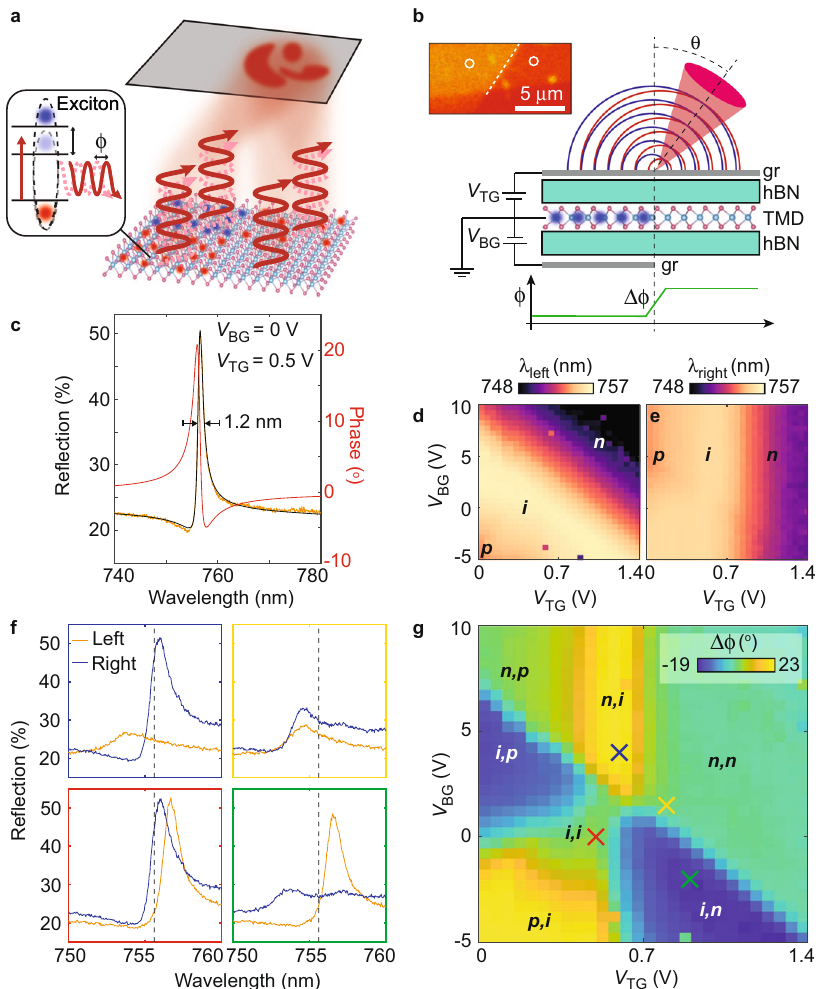
Fig. 1 Continuously tunable phase patterning in a van der Waals heterostructure. a Schematic of our approach: patterned electrostatic doping of atomically thin transition metal dichalcogenides (TMDs) allows for spatial control of the exciton resonance (inset). Thus, a continuously tunable phase pro fi le is imparted on the re fl ected wavefront, enabling wide-ranging possibilities for beam control. b Schematic of SG-FET structure. Since the bottom gate only covers part of the device, the phase can be tuned independently in the two sides. The phase discontinuity in the re fl ected wavefront causes the two halves to constructively interfere at an angle in the far fi eld. Inset: zoomed-in optical microscope image of the device, with gate edge indicated by white dashed line. c Representative re fl ection spectrum (orange) from left side of gate edge in intrinsic regime ( V BG = 0 V and V TG = 0.5 V), with asymmetric resonance fi t (black), which allows for extracting the phase (red). d , e Gate dependence of λ left and λ right , respectively (locations indicated by circles in inset of b ). The exciton resonance blue-shifts upon electrostatic doping. While λ left depends on 8 V TG + V BG , λ right is largely independent of V BG . The intrinsic regime appears at an offset of V TG = 0.5 V, likely due to charge collection at the top gate. The small voltage range of the intrinsic regime suggests some doping via in-gap states. f Re fl ection spectra from left (orange) and right (blue) side of gate edge at different gate voltage combinations shown as correspondingly colored crosses in g . Dashed gray line indicates λ 0 = 755.6 nm. g Gate dependence of phase difference Δ ϕ between the right and left side at λ 0 = 755.6 nm, computed from fi ts as in ( c ). A tunable Δ ϕ -range of 42° is achieved. Large positive Δ ϕ is achieved when λ left < λ 0 < λ right (blue cross), while large negative Δ ϕ is achieved when λ right < λ 0 < λ left (green). Δ ϕ is closer to zero when either both sides are doped ( λ left , λ right < λ 0 ; yellow) or both are intrinsic ( λ 0 < λ left , λ right ; four regimes (colored circles) and Fourier images without back- ground subtraction (insets). We fi nd that the re fl ection is de fl ected in the expected direction, perpendicular to the gate edge. The tunable de fl ection range is 9.8°, in very good agreement with theoretical predictions based on the phase difference range observed in Fig. 1g.